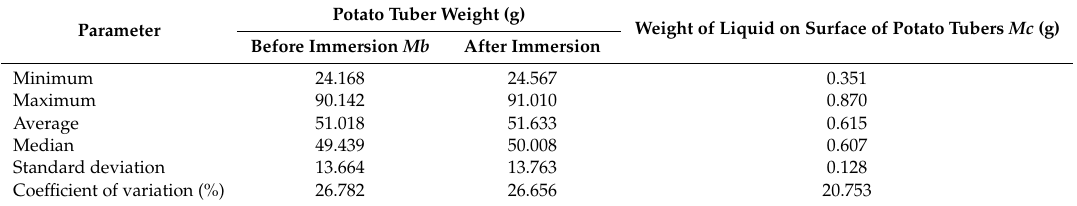
Table 1. The statistical characteristics of the potato tuber weight before and after immersion in the working liquid and the weight of the working liquid on the potato tubers (the first stage of the tests).